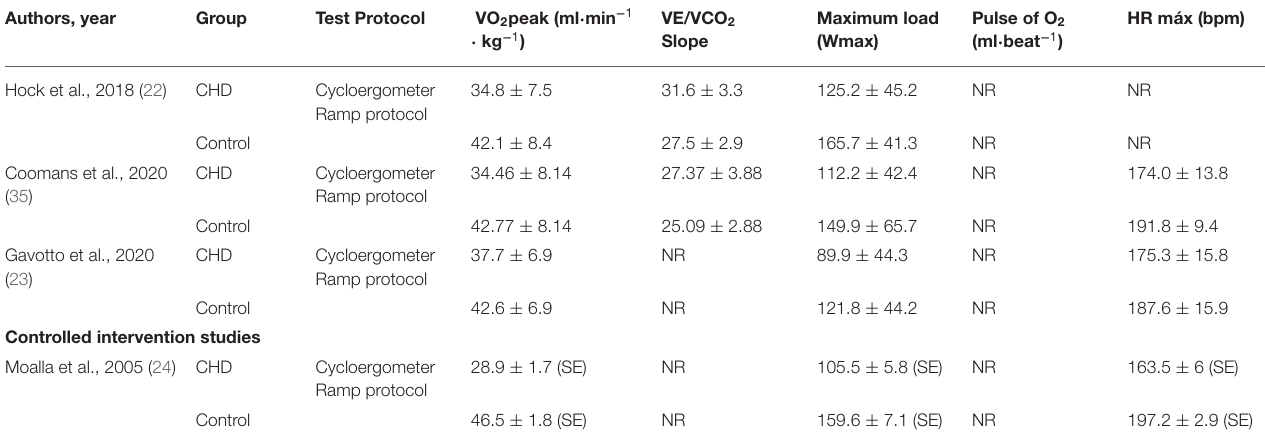
controls. The heterogeneity of the comparison was high (I 2 = 73%). Participants with CHD had on average − 2.4 ml/beat of O 2 pulse (95% CI: − 3.7, − 1.1 ml/beat) compared with controls ( p < 0.0003) ( Figure 7 ). If we analyse only studies with patients surgically repaired (19, 27, 36) the participants with CHD averaged − 3.1 ml/beat (95% CI: − 4.0, − 2.1) of